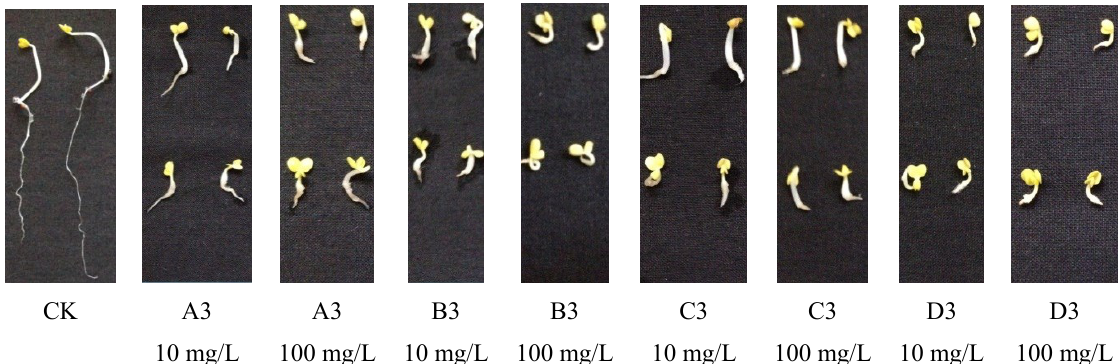
Figure 2. Photographs showing the lateral root and stalk development of dicotyledon rape